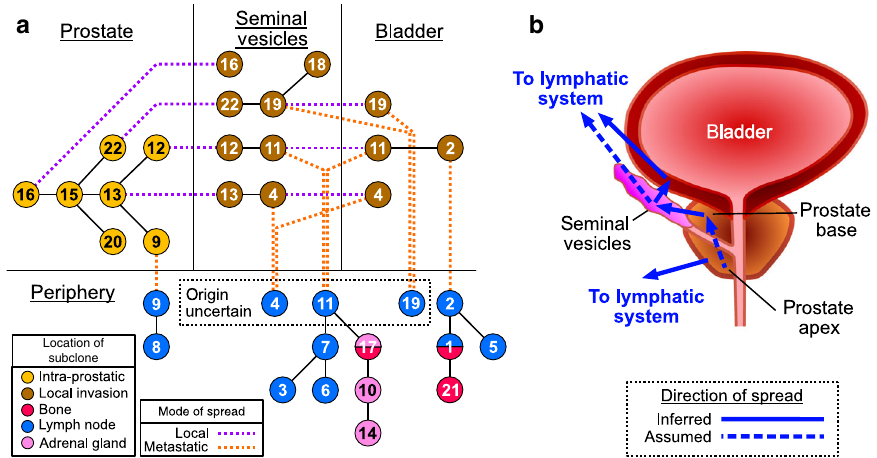
Fig. 3 Multi-clonal invasion into adjacent organs and subsequent metastatic seeding in A22. Subclones identi fi ed in each sample were considered in conjunction with the phylogenetic trees to distinguish invasive local spread, evolutionary progression, and origins of metastatic dissemination. a A compound phylogenetic/compartmental diagram where lineages can move between compartments (dotted lines, purple = local invasion, orange = distant spread) and undergo subclonal expansion (solid black lines). Compartments were Prostate, Seminal Vesicles, Bladder and Periphery as labeled. Subclones are denoted by circles colored by tissue type, with numbers corresponding to clusters in Supplementary Fig. 5. b Spread of metastatic lineage occurred fi rst through transprostatic migration to the base of the prostate, then to seminal vesicles and then to the bladder. At least one metastatic lineage (corresponding to subclone 2) was seeded from the bladder, and lineages identi fi ed through subclones 4, 11, and 19 may have originated from either the bladder or seminal vesicles (denoted ‘ origin uncertain ’ ). An additional metastatic lineage (subclone 9) appeared to have seeded directly from the